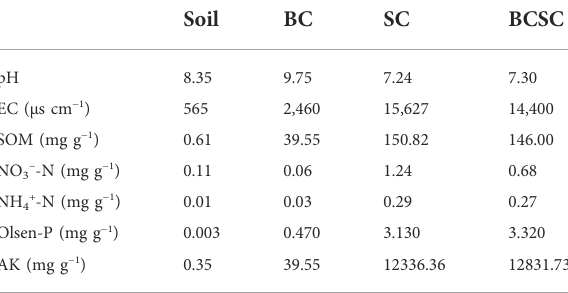
TABLE 1 Selected chemical and physical characteristics of the soil, biochar, and compost